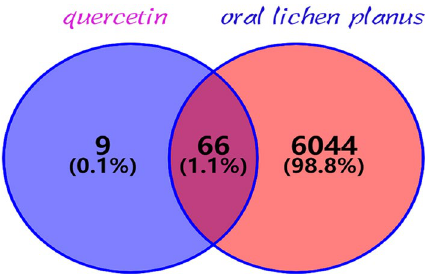
Figure 2. The purple circle on the left represented the targets of quercetin, and the orange circle on the right represented the differentially expressed genes in oral lichen planus (OLP). The overlap part of the two circles represented the common targets of quercetin and